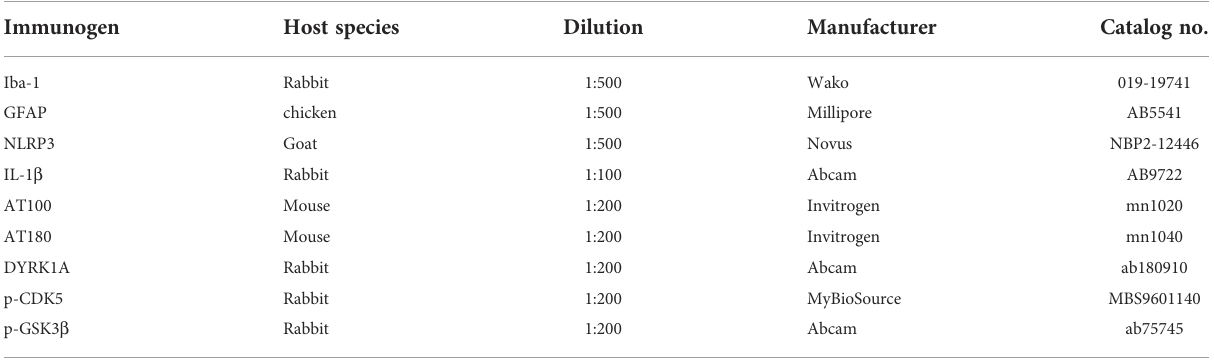
TABLE 1 List of primary antibodies used for